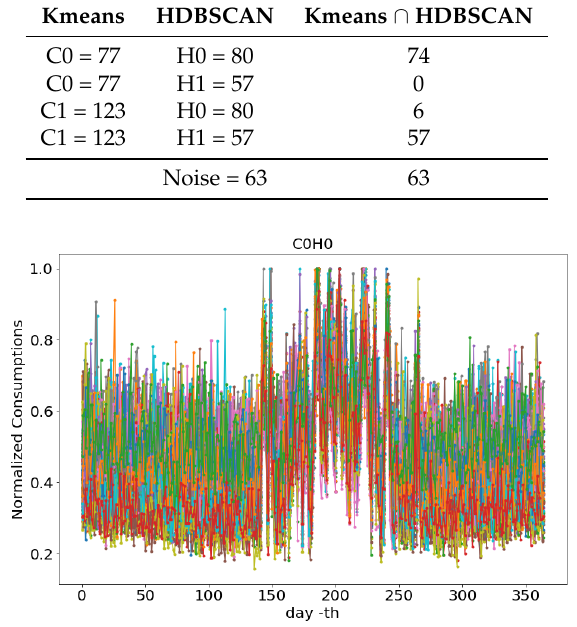
Figure 14. The Mix Pattern of